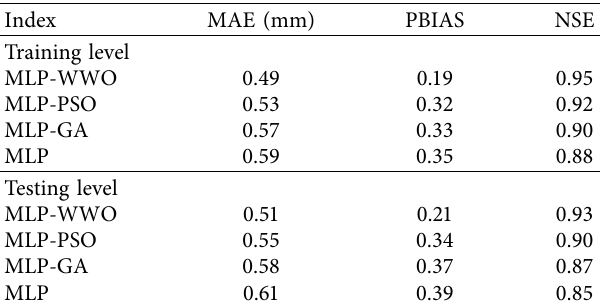
Table 5: The training level for the statistical results related to the soft computing models based on the monthly scale.